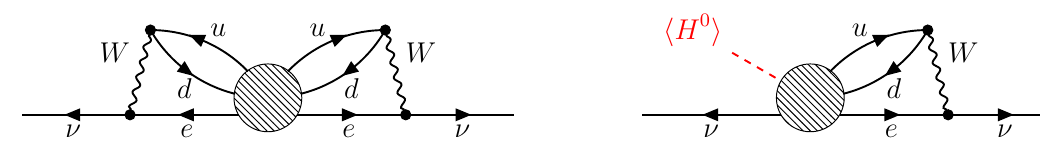
Figure 12 . The black box diagrams for neutrino masses from 0 νββ decay effective vertices. The diagram in the left panel can generate Majorana neutrino masses if 0 νββ decay is observed, while the diagram in the right panel can generate Majorana neutrino masses from the long-range 0 νββ decay operator. In the UV decomposition of the current work, the effective vertex of the long-range 0 νββ operator is realized by a one-loop diagram, which means the neutrino masses are generated at most at three-loop